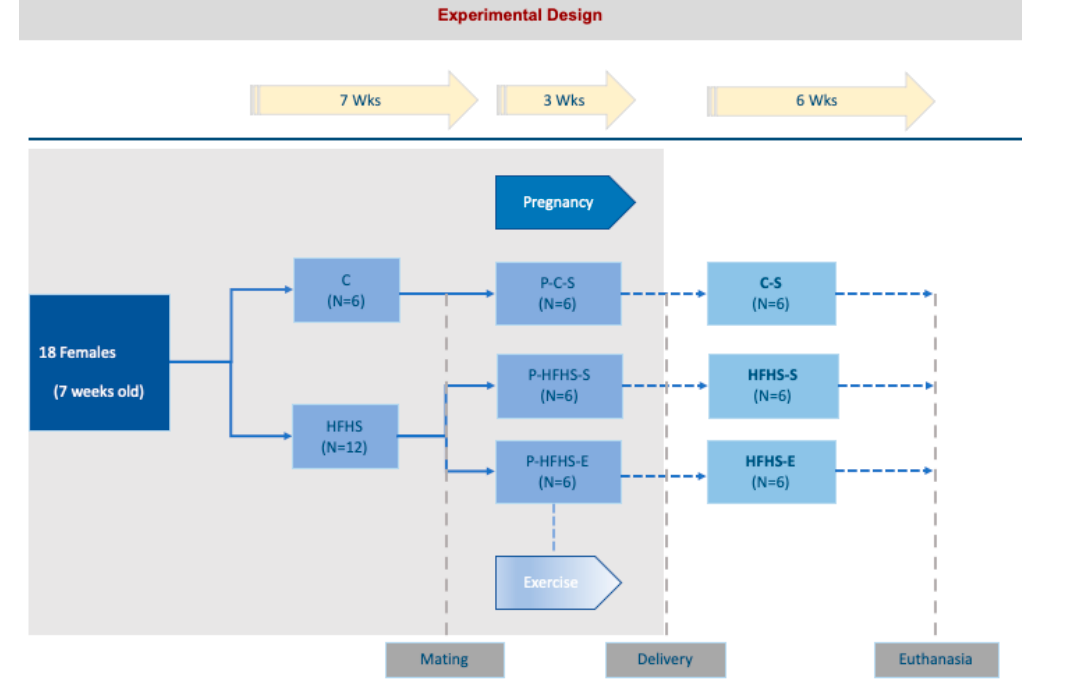
Figure 9. Schematic representation of the experimental design. Seven-week-old female Sprague- Dawley rats were fed with experimental diets—control (C) and a high-fat, high-sucrose (HFHS) diet, and after 7 weeks were mated with sedentary male Sprague-Dawley rats. After 3 weeks of nursing, male offspring were weaned and identified as ( n = 6 per group): as C–S offspring from P–C–S, HFHS–S offspring from P–HFHS–S, and HFHS–E offspring from P–HFHS–E. Thereafter, offspring were fed with standard laboratory pellet chow and remained sedentary until 6 weeks of age, when they were